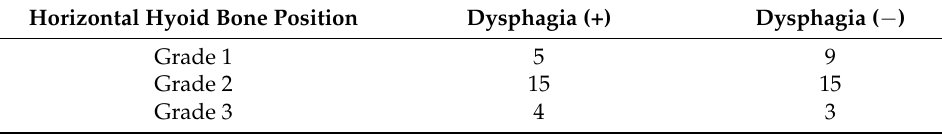
Table 3. Prevalence of the horizontal hyoid bone position.